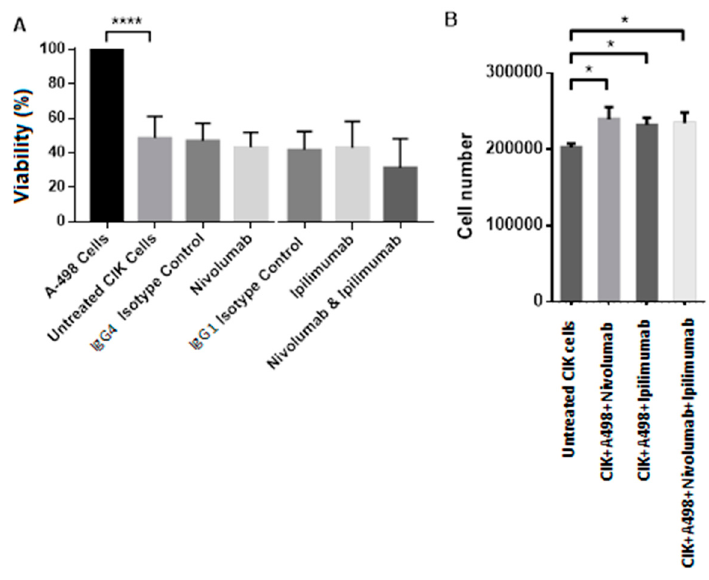
Figure 7. Effects of nivolumab and ipilimumab and control antibodies on the number of viable cells after 72 h of coculture of A-498 with CIK cells. n = 3 healthy donors. Absorbance values have been standardized into percentages with each untreated control equaling to 100%. ( A ) Coculture of CIK cells and A-498 in a ratio of 10:1 with nivolumab with a combination treatment of nivolumab plus ipilimumab compared to untreated CIK cells, p value = 0.4425. ( B ) Number of viable CIK cells after 72 h treatment with 20 ug/mL nivolumab plus 20 ug/mL ipilimumab in the presence of A-498 compared to untreated CIK cells, p value= 0.0210. **** represents a p value < 0.0001, * represents a p value < 0.05.